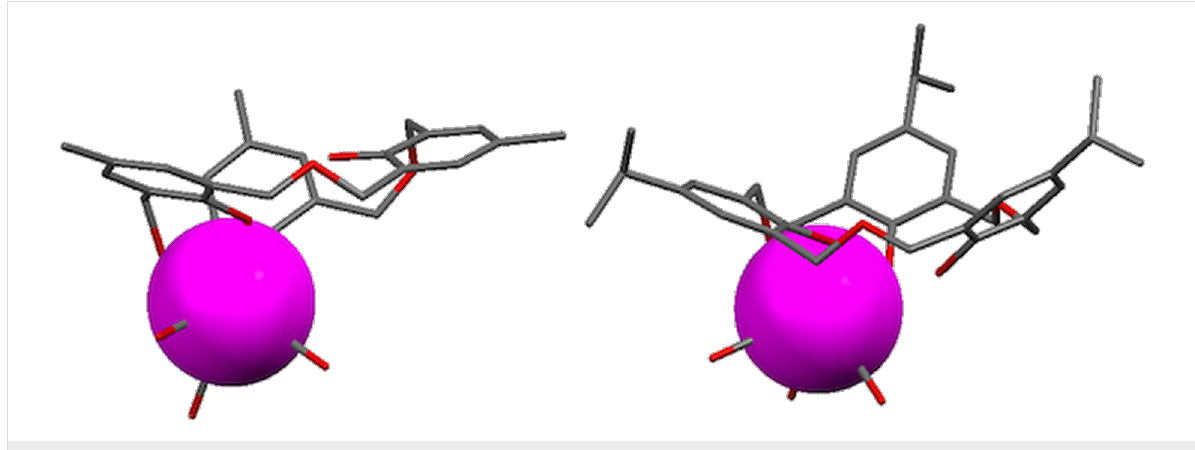
Figure 16: X-ray crystal structures of oxacalix[3]arene complexes with rhenium: 3b ∙ Re(CO) 3 (CCDC ID 620981, left) and 3d ∙ Re(CO) 3 (CCDC ID 620982, right) [49].